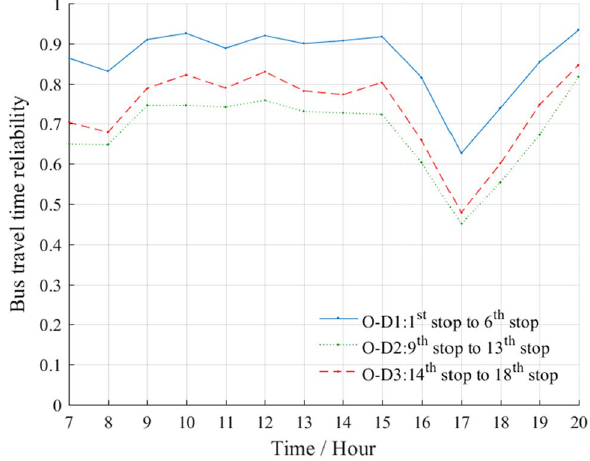
Fig. 7 Bus travel time reliability of different O–D